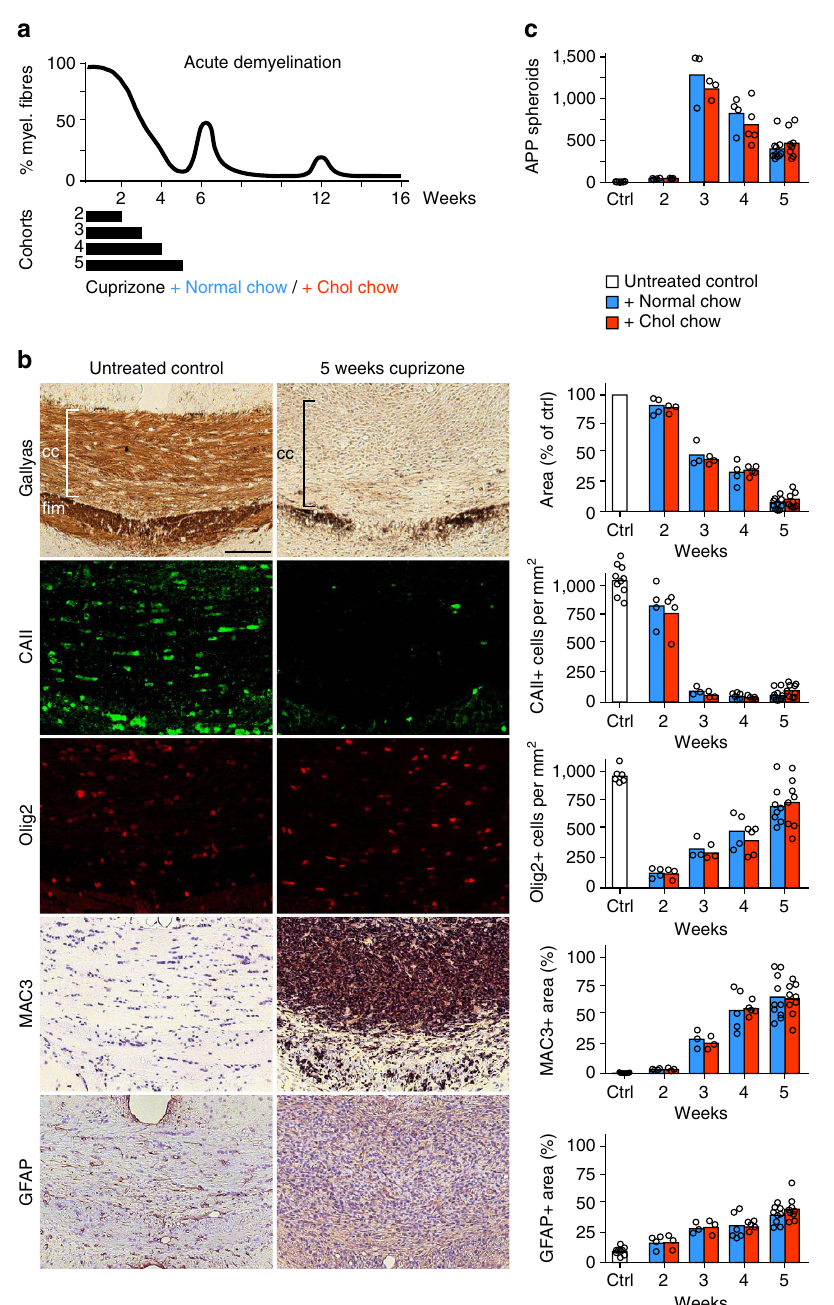
Figure 3 | Cholesterol does not affect cuprizone mediated demyelination. ( a ) Scheme depicting the time course of demyelination/remyelination during 6 week cuprizone feeding (upper panel, based on own results and on other studies 25,28 ) to the treatment paradigm. To assess the influence of high- cholesterol feeding on demyelination, mice on normal chow or high-cholesterol chow additionally received cuprizone in the diet for between 2 and 5 weeks (black bars) after which mice were analysed histologically. ( b ) Representative pictures of the corpus callosum of untreated control mice and mice after 5 weeks on cuprizone with the corresponding quantification on the right. Assessed were myelination (Gallyas silver impregnation), the number of mature oligodendrocytes (CAII), the number of oligodendrocyte lineage cells (Olig2), activated microglia (MAC3) and astrocytes (GFAP). Each bar represents the mean value for 3–5 (week 2–4) or 9–10 (week 5; untreated controls, ctrl) animals per condition with individual data points (scale 100 m m). ( c ) APP positive spheroids per mm 2 in the corpus callosum at the end of 2–5 weeks of cuprizone with or without cholesterol supplementation ( n ¼ 3–4 animals at 2 and 3 weeks, n ¼ 4–5 at week 4, n ¼ 6 untreated controls, n ¼ 9–10 at week coordination 34 (Supplementary Fig. 7). The Vmax of mice remyelinated on normal chow dropped to about 40% of levels on the training wheel, and did not improve above 75% (Fig. 5g).